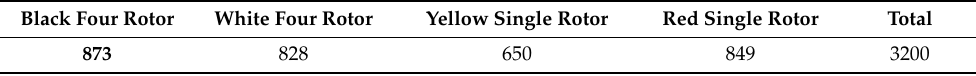
Table 2. UAV detection